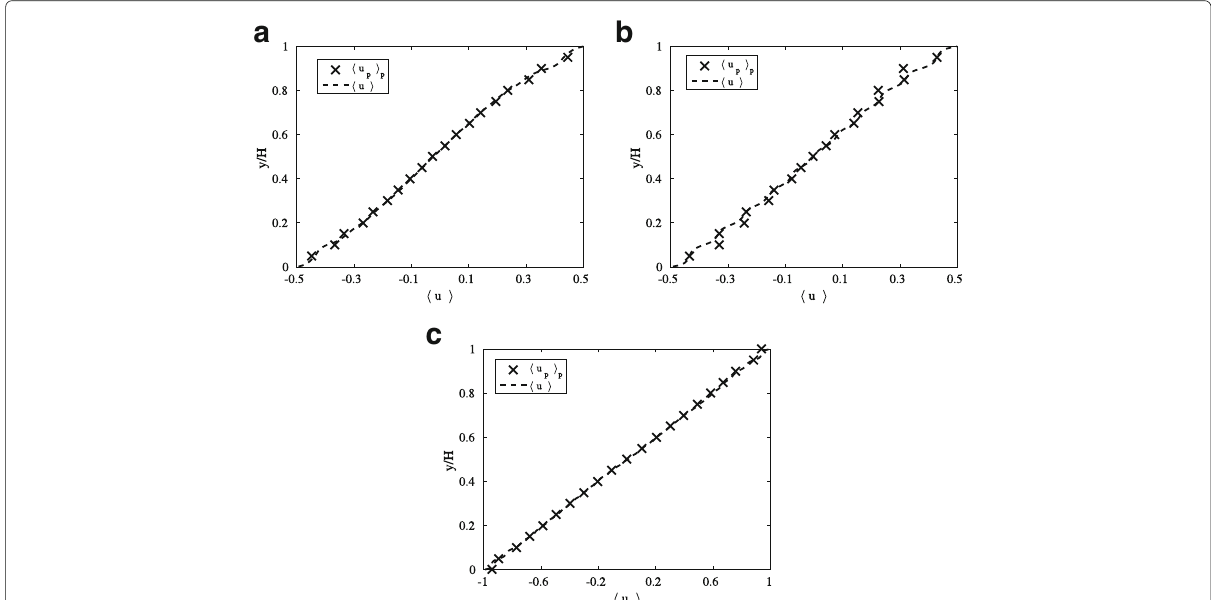
Fig. 7 Average streamwise particle velocity profiles for the three simulation scenarios: a Re = 10 and φ v = 0.42, b Re = 10 and φ v = 0.54, and c Re = 40 and φ v =